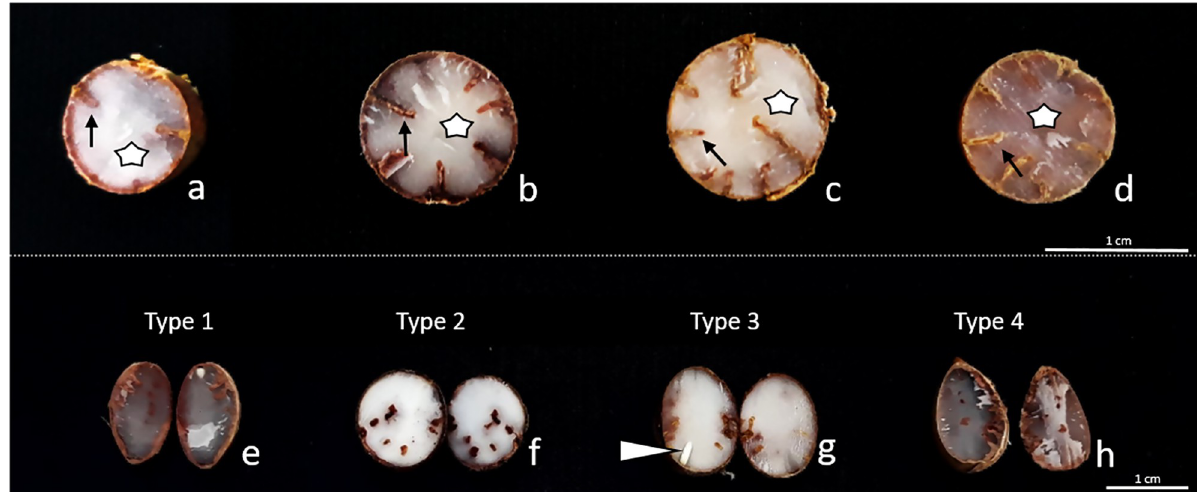
Fig 7. Seeds of Copernicia alba (Arecaceae) in cross section (a-d) showing tegument with infoldings (arrow) and endosperm (white star) in each type. Seeds in longitudinal section (e-h): tegument, endosperm and embryo (arrow head). Scale bars: 1 cm.